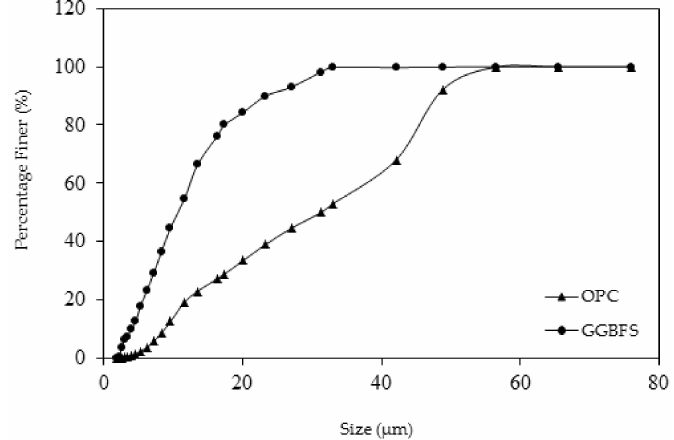
Figure 1. Particle size distribution of the ordinary Portland cement and ground granulated blast furnace slag.